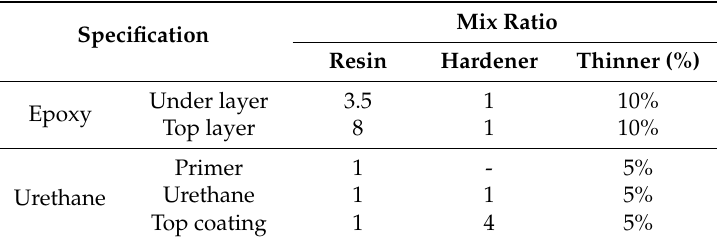
Table 7. Mix design of epoxy and